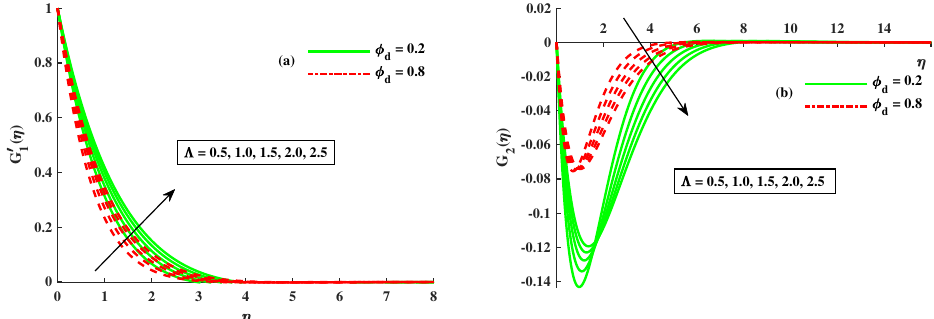
Figure 4. Fluctuation of R and φ d on G 1 p ( η ) and G 2 p ( η ) .